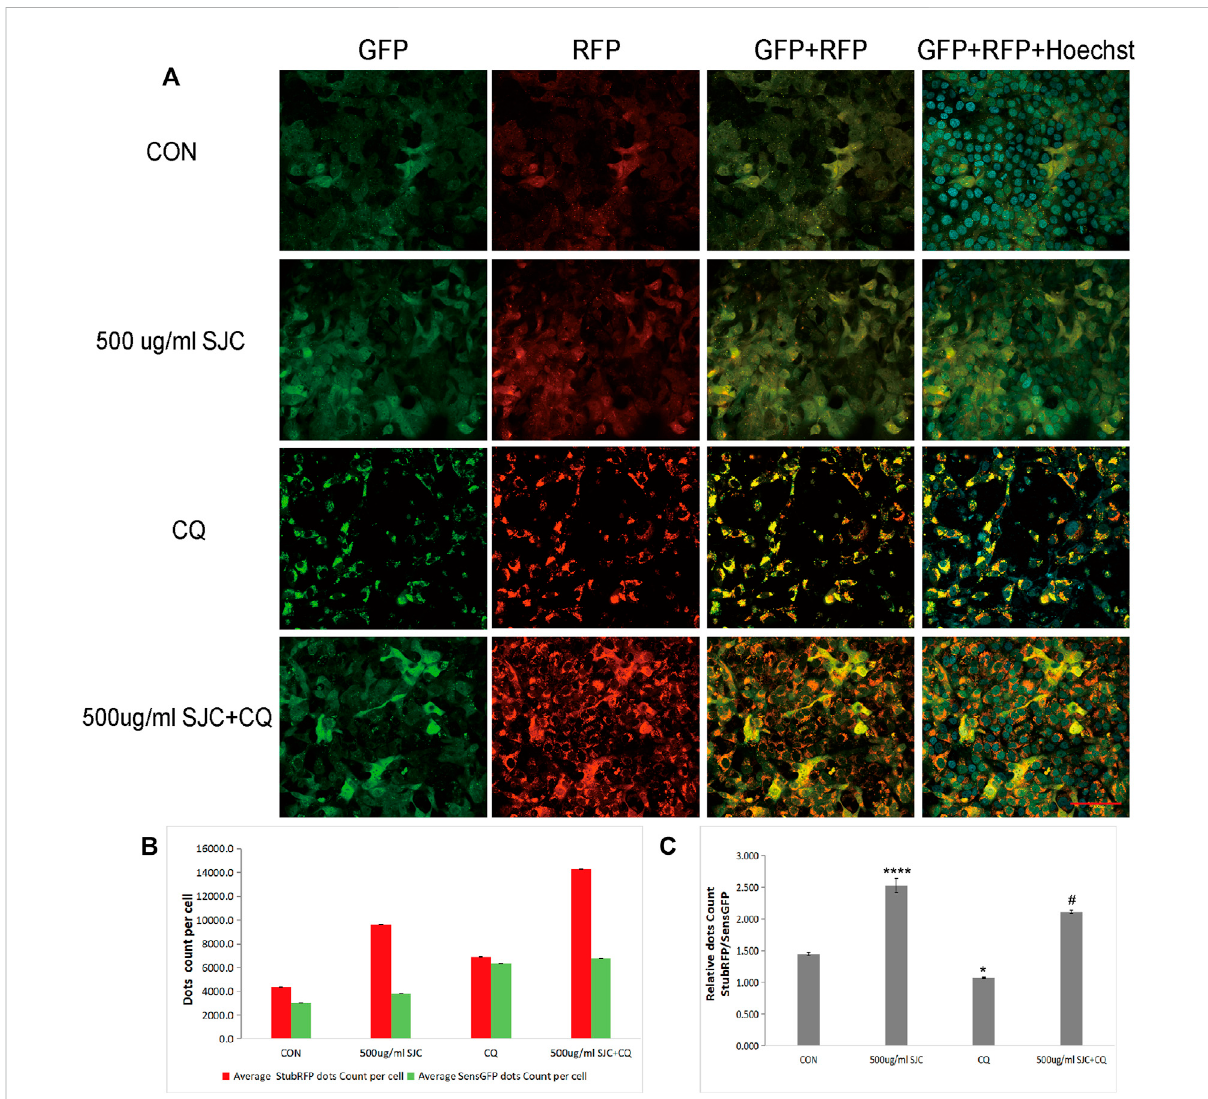
FIGURE 8 Differences in LC3 fl uorescence expression in the SJC group before and after chloroquine treatment. (A) Cell morphology and fl uorescence expression of the SJC group and the control group in the presence and absence of chloroquine were observed with confocal laser microscopy. (B) Histogram of StubRFP and SensGFP expression of LC3 in each group. (C) Histogram of StubRFP/SensGFP ratios. Compared with CON, * p < 0.05, ** p < 0.01, *** p < 0.001, **** p < 0.0001; Compared with 500 μ g/ml SJC, # p <